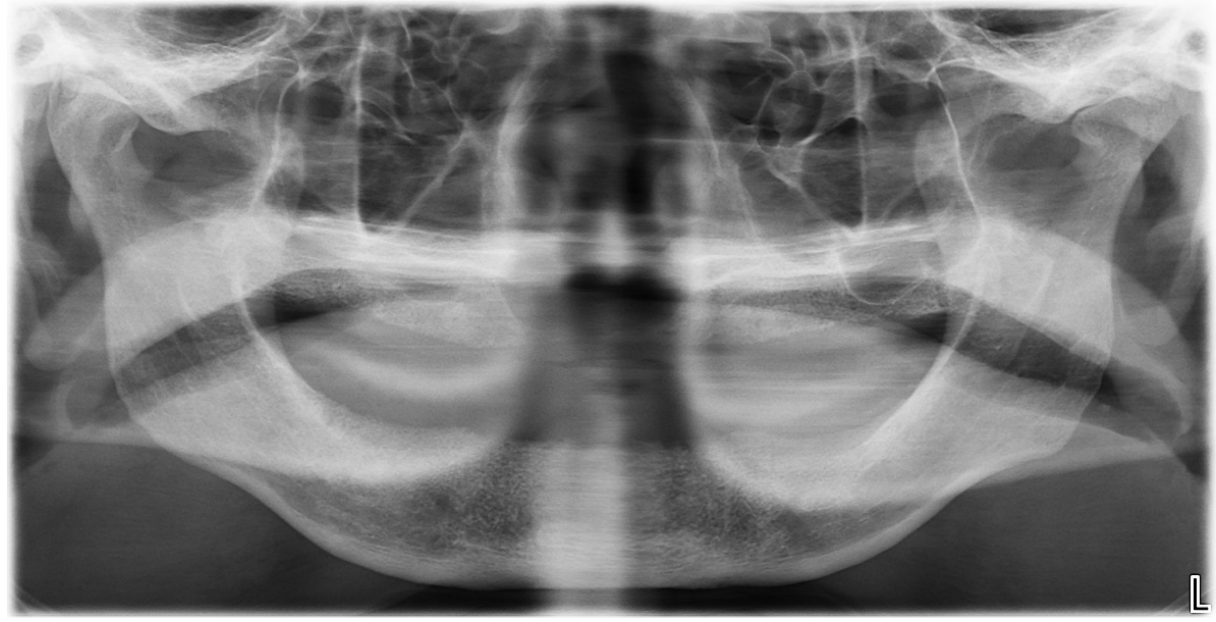
Figure 1. Panoramic X-ray at first examination.